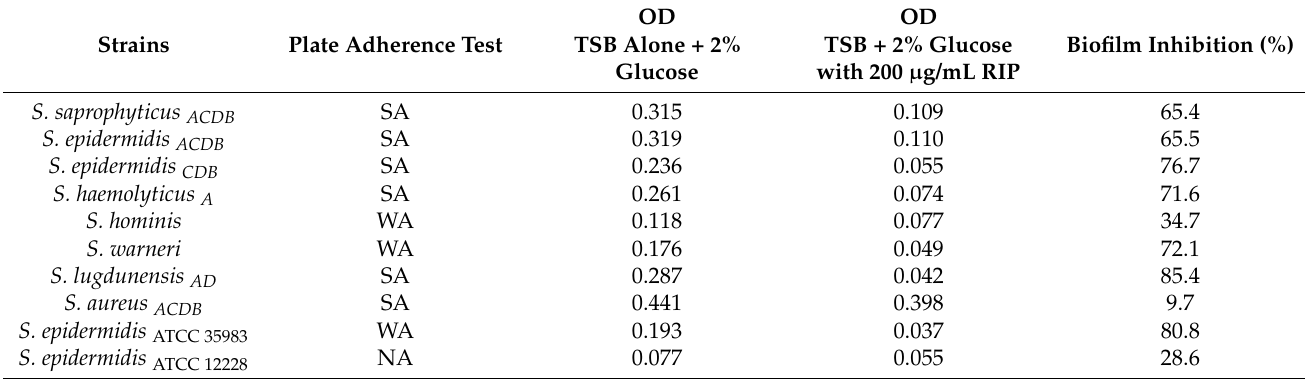
Table 3. Quantification of biomass and percentage of inhibition of biofilm formation by RIP using polystyrene plates: TSB alone + 2% glucose and TSB + 2% glucose with 200 µ g/mL